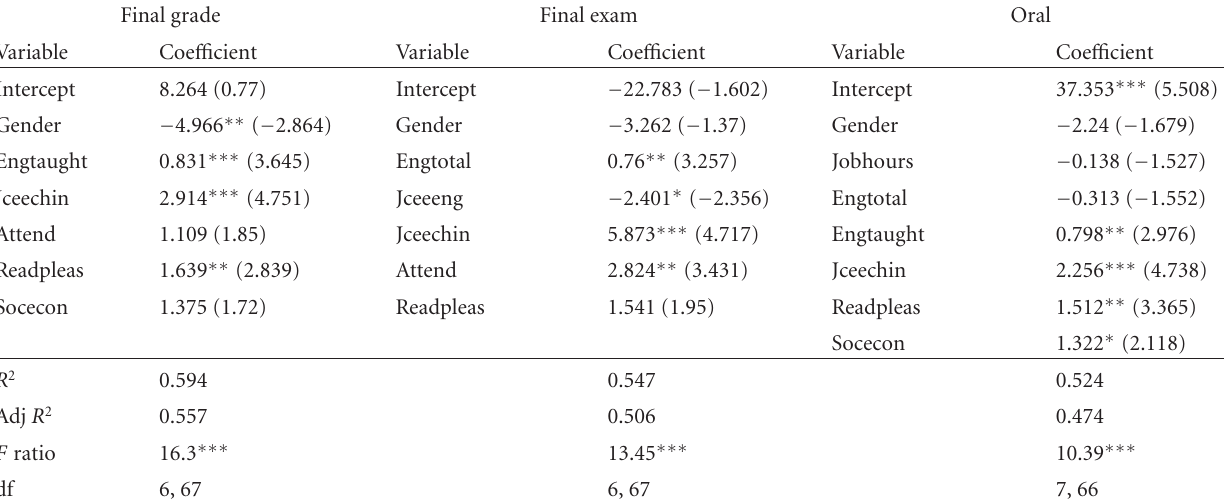
Table 4: Regressions for dependent variables: finalgrade, finalexam, and